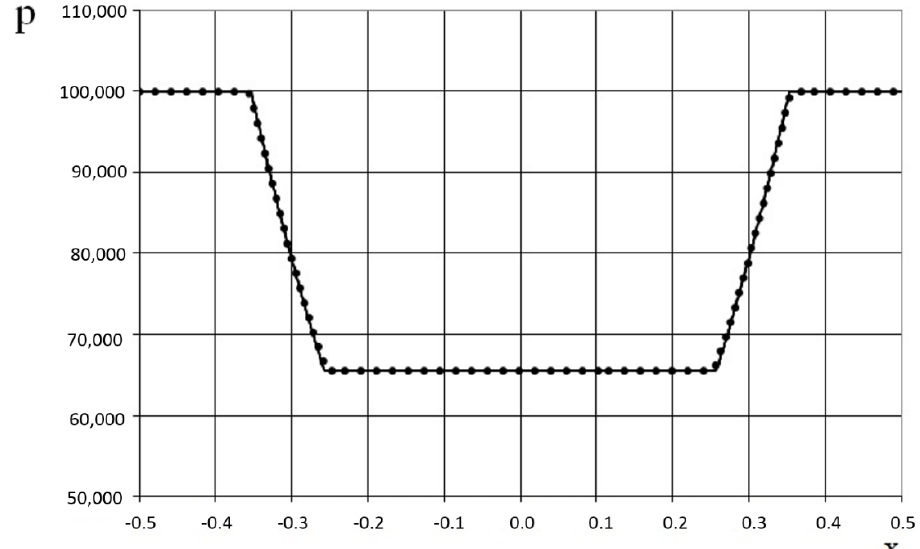
Figure 22. Pressure plot for the double expansion wave problem (47) for the one-dimensional scalar hyperbolic conservation law, using the finer grid (1000 grid points): the exact solution (solid line), and the present method (dotted line).